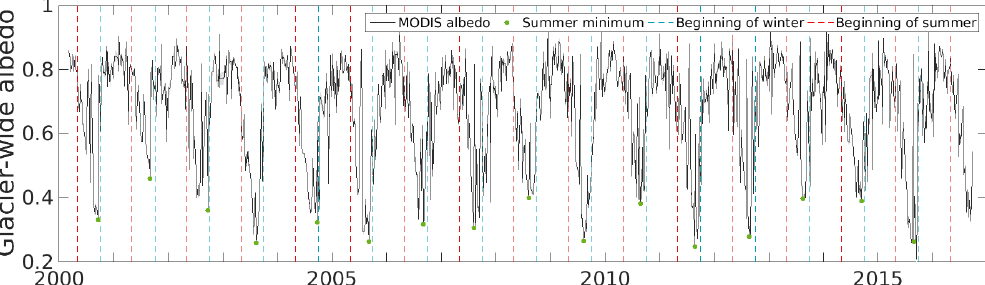
Figure 4. The ∼ 16-year albedo course for Saint-Sorlin Glacier. Glacier-wide averaged albedo is represented with the continuous black line. The green dots spot for each summer the minimum average albedo, and have been manually checked for all years and glaciers. Dashed red and blue lines stand for the beginning of the defined ablation and accumulation seasons (May and 1 October